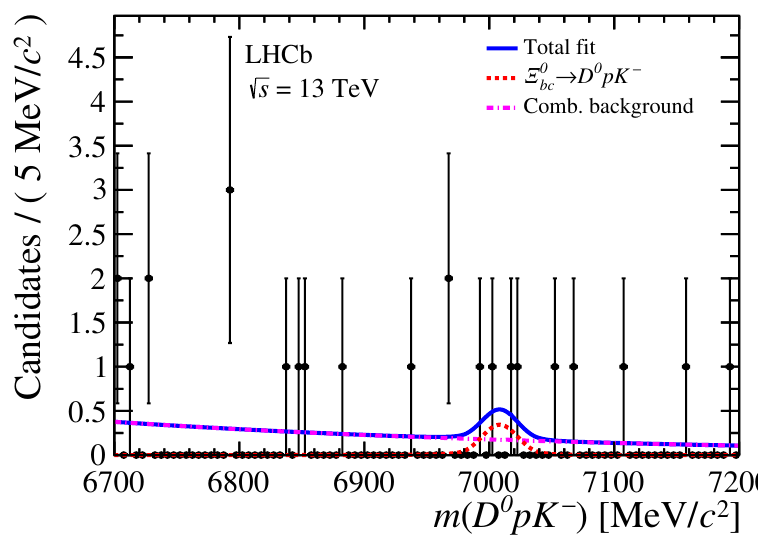
Figure 2 . Invariant mass m ( D 0 pK (cid:0) ) distribution of selected (cid:4) 0 gether with the projection of the (cid:12)t (blue solid line) for the full data sample. The (cid:4) 0 signal component, with the central mass value varying freely (red dashed line), and combinatorial background (purple dotted line) are also